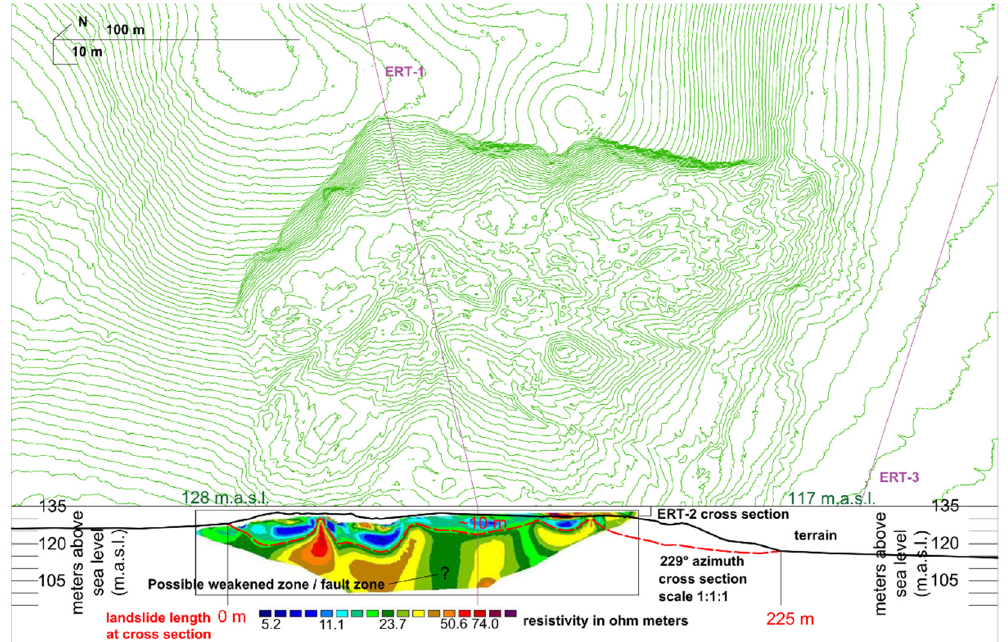
Figure 11. Hrvatska Kostajnica landslide cross section (perpendicular to movement) and interpreted ERT-2 data. At cross section area the length of the landslide is 225 m with slide surface at the depth of ~10 m. In the middle part of the cross section possible fault zone is present (marked with question mark). The contour line interval on the topographical map is 1 m.